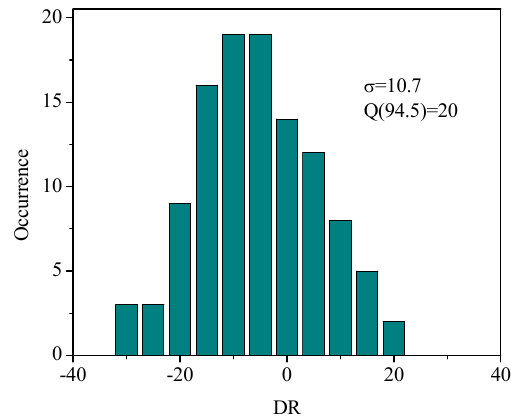
Fig. 3. Two-dimensional maps of DR on 9 May 2008 from 1500 to 1800 LT, respectively. The red star and black circles denote the epicenter and ionosondes, respectively.